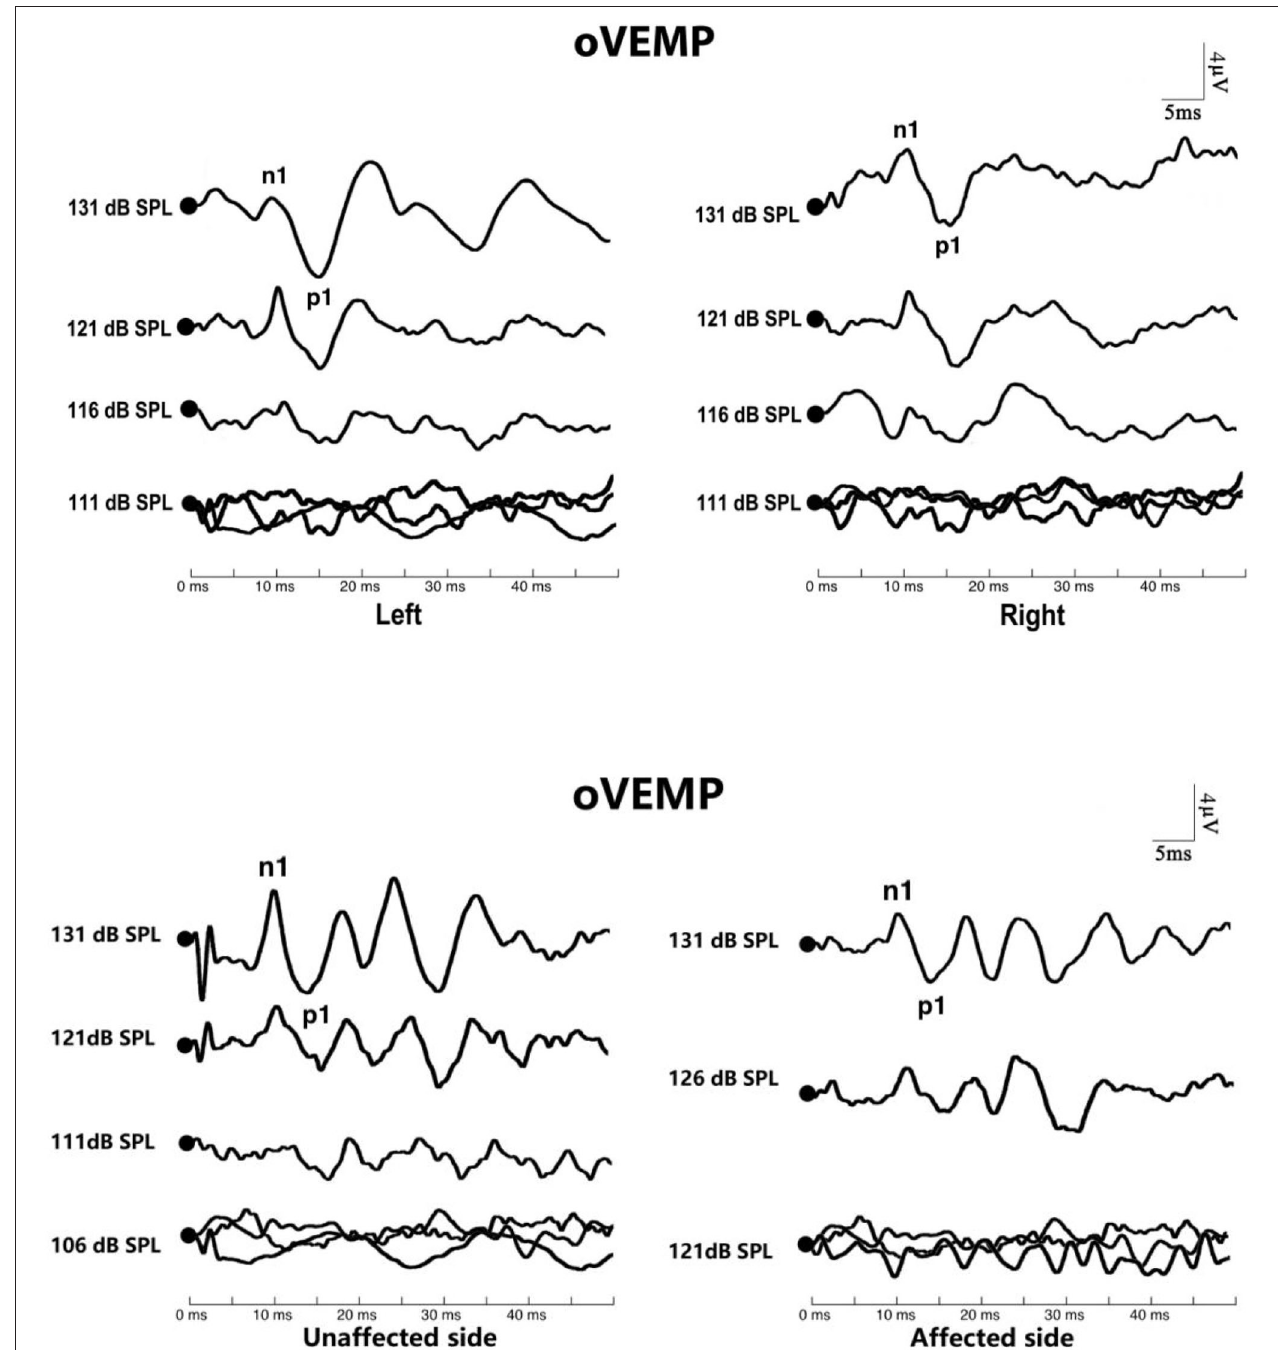
FIGURE 3 | Ocular vestibular-evoked myogenic potential (oVEMP) in affected ears with benign paroxysmal positional vertigo (BPPV). The top picture shows the oVEMP response of a normal subject. The bottom picture shows the oVEMP response of a patient with BPPV.